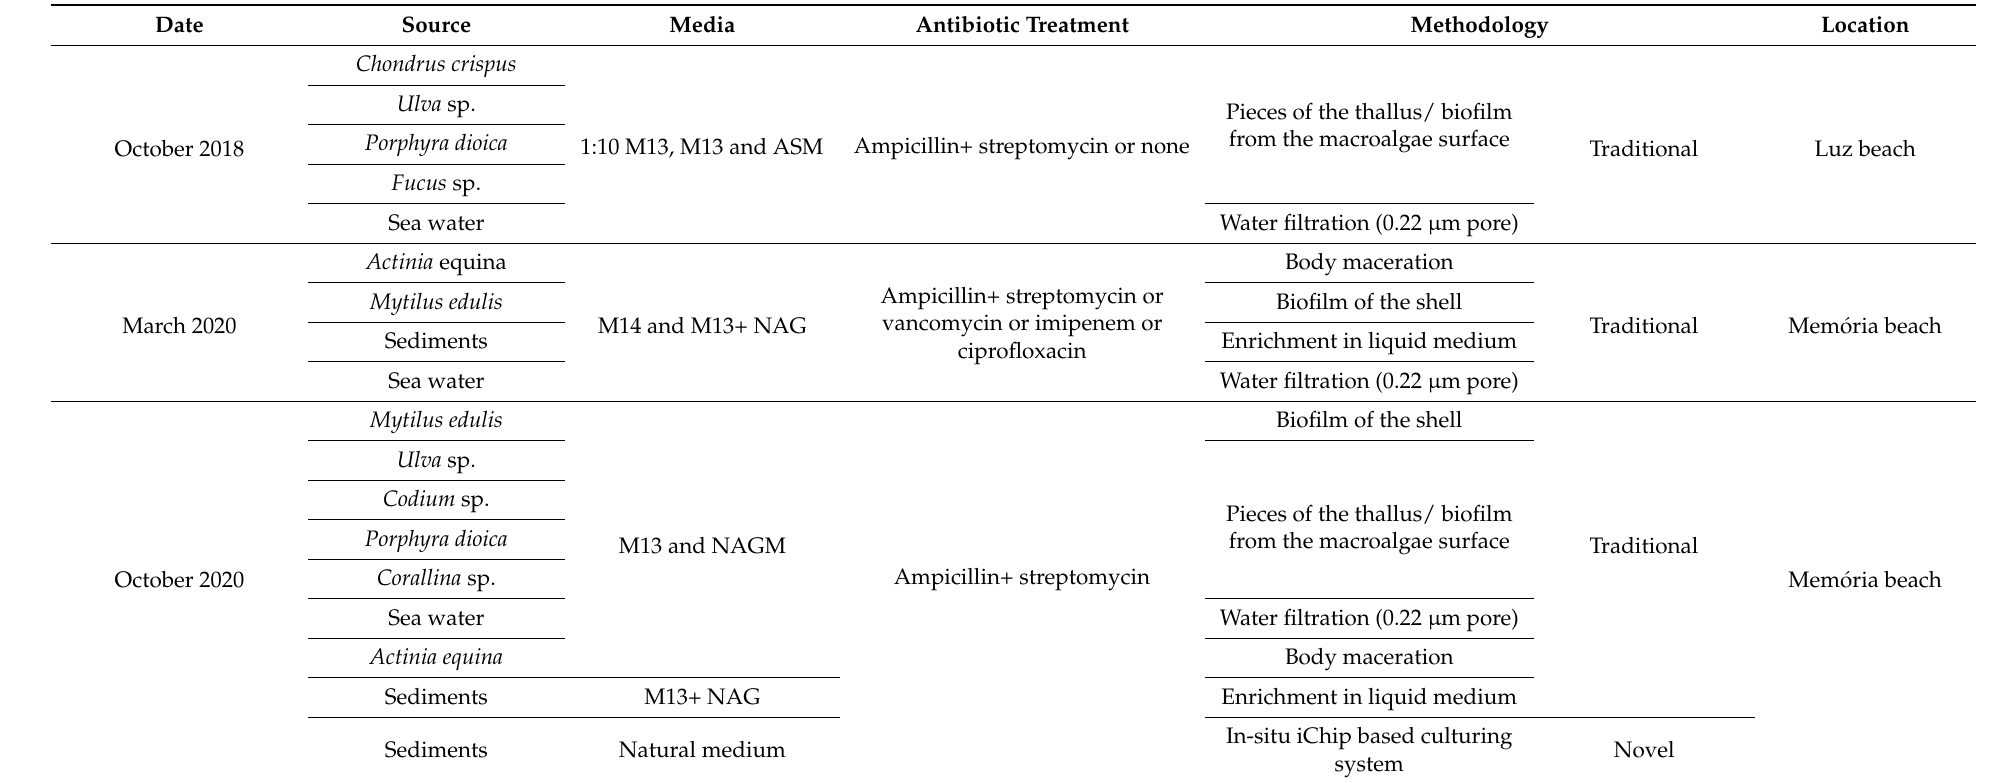
Table 1. Details of the three planctomycetal isolation